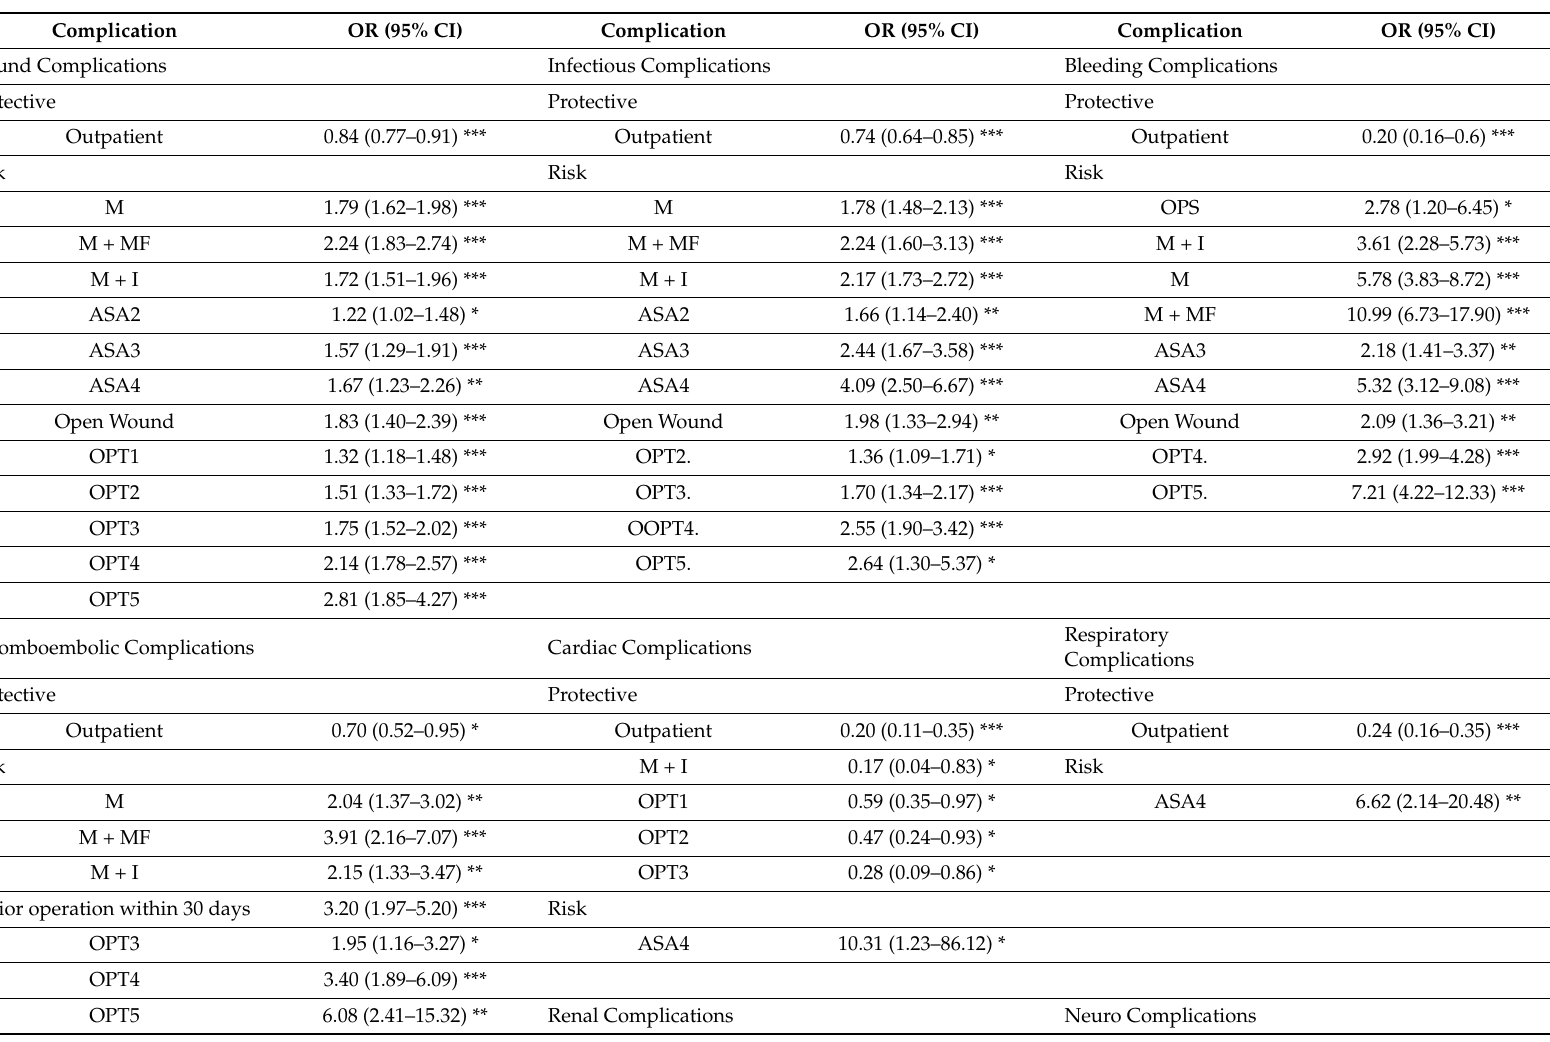
Table 7. Multivariable logistical Regression Analysis of 30-Day Complication Rate: Surgical Predictors of